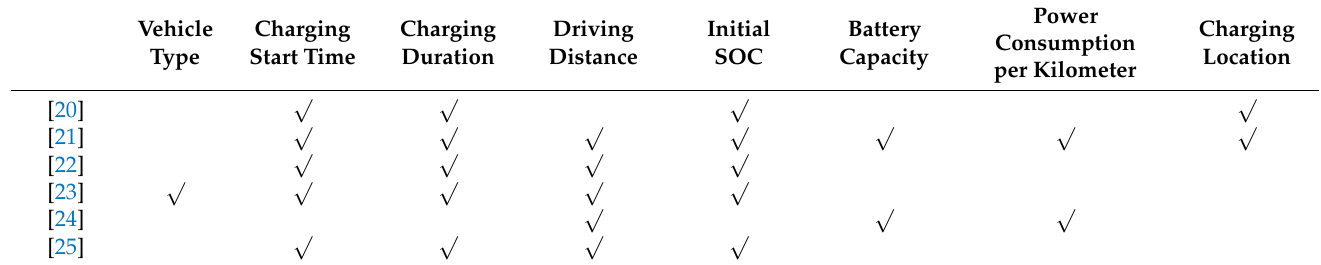
Table 1. Influencing factors of EV charging